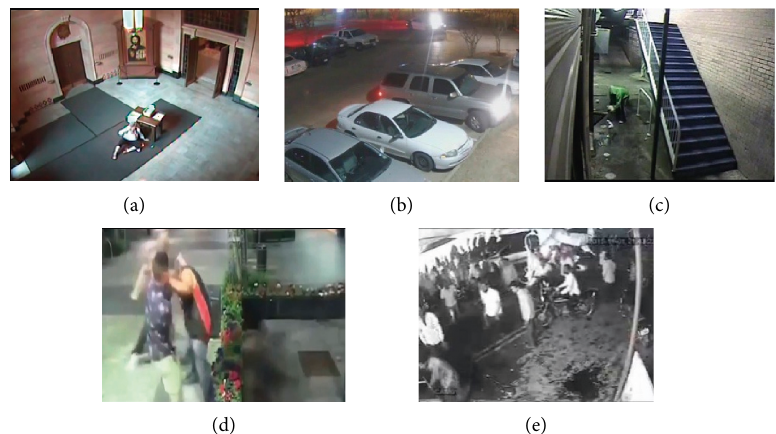
Figure 1: Sample images of five different human activities: (a) abuse, (b) arrest, (c) arson, (d) assault, and (e)